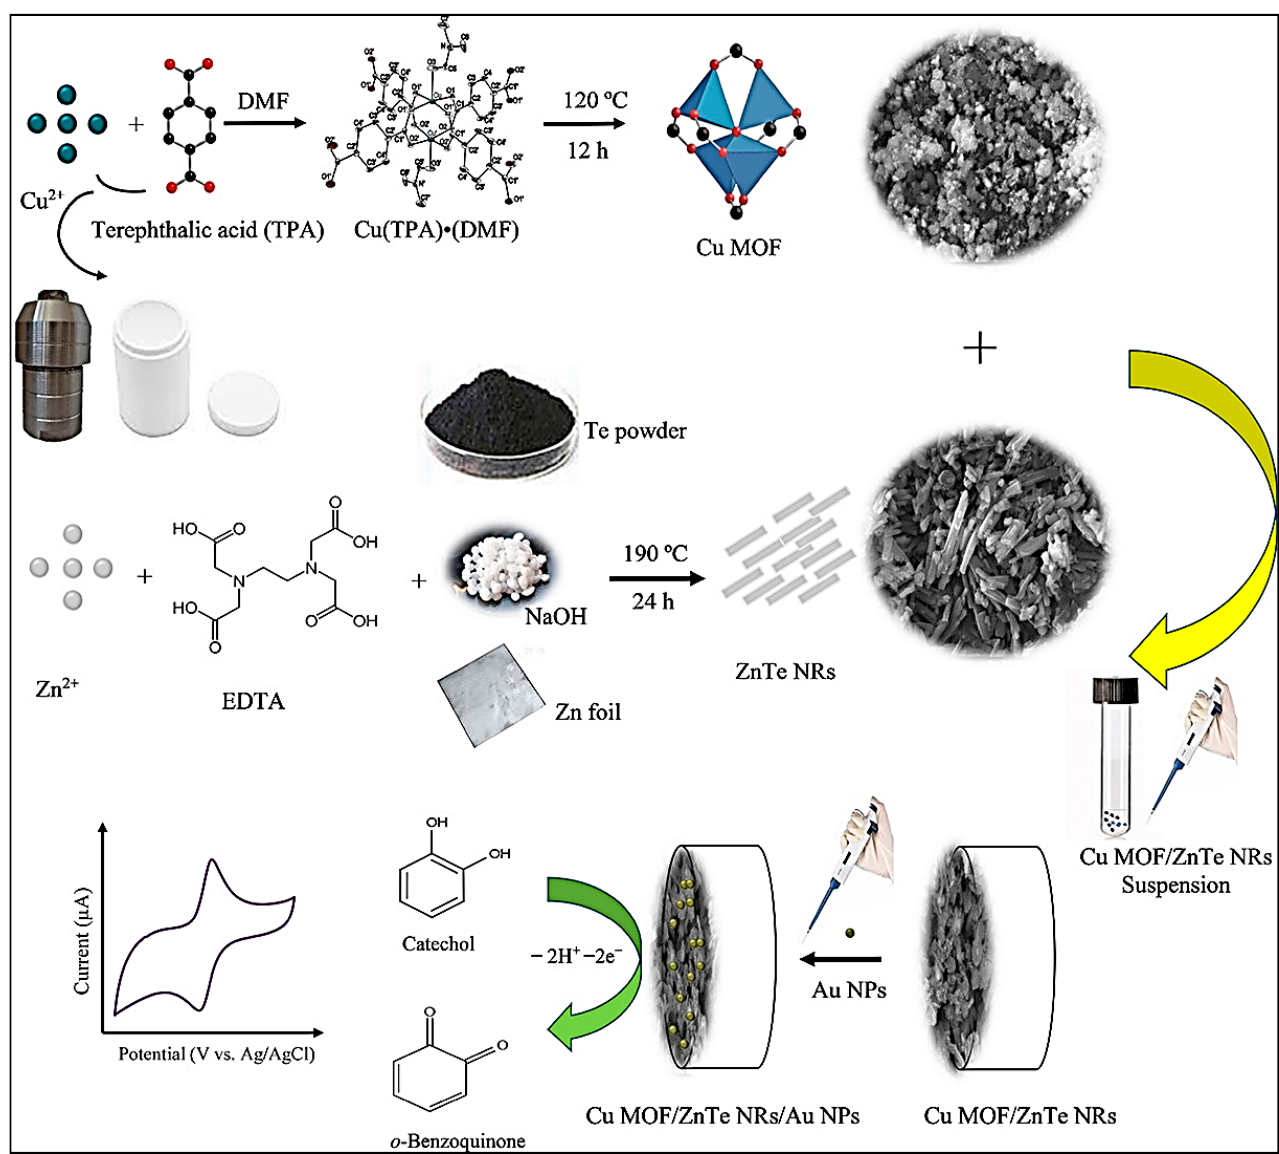
Figure 7. Preparation of porous Cu-MOF/ZnTe nanorods/AuNPs hybrid and its layer-by-layer deposition on the surface of GCE for catechol determination. Reproduced with permission from [127].